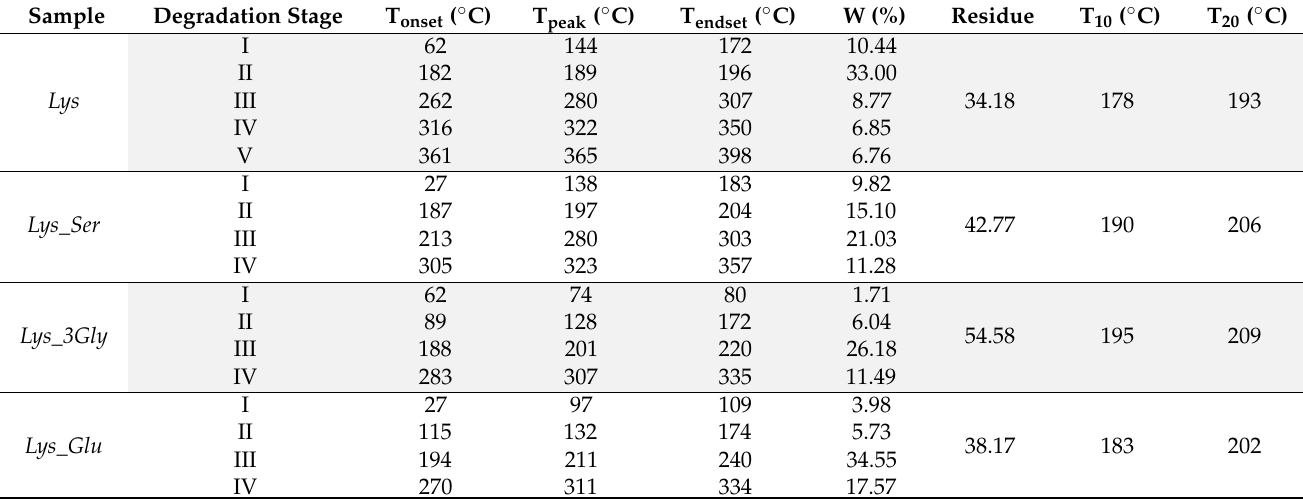
Table 3. The main parameters of the thermal analysis.